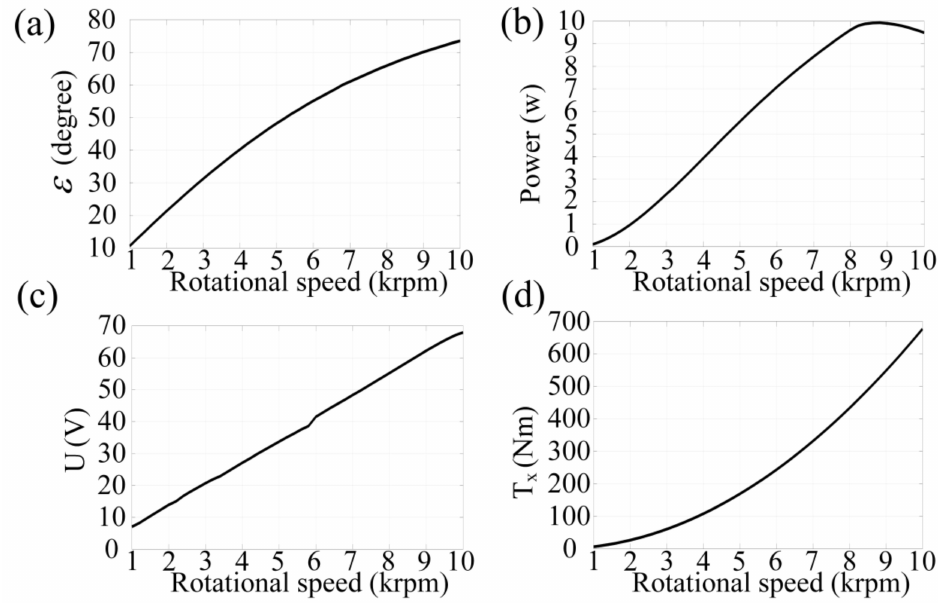
Figure 10. The effect of flywheel rotational speed: ( a ) flywheel precession angular displacement; ( b ) output power; ( c ) voltage; ( d ) torque in x